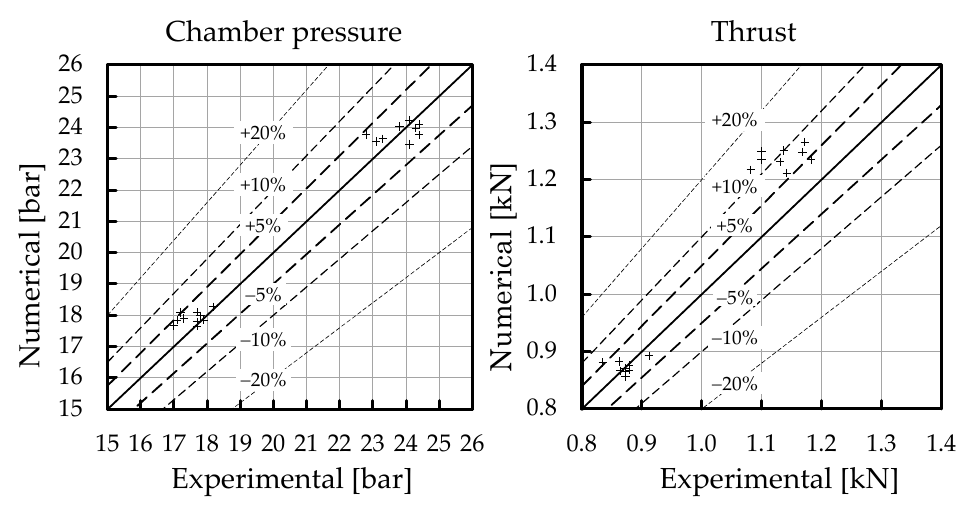
Figure 13. Comparison between experimental and numerical results.